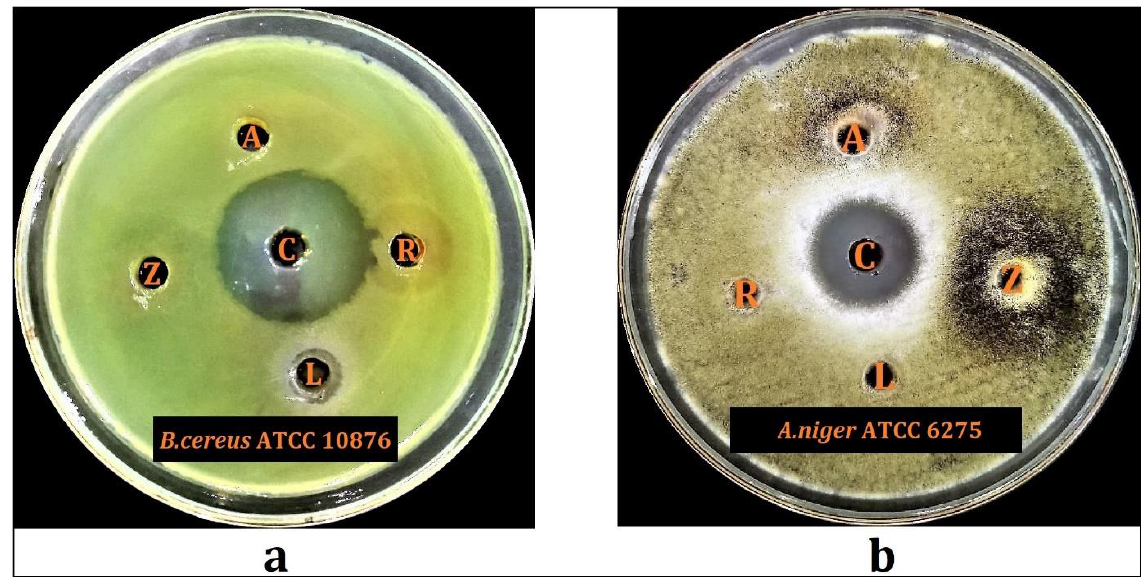
Figure 5. Results of preliminary antimicrobial activity evaluations against, ( a ) B. cereus 10876; ( b ) A. niger 6275 for Lycium shawii ( L ), Anabasis articulata ( A ), Rumex vesicarius ( R ), Zilla spinosa ( Z ) plants’ hydroalcoholic extracts, and control antibiotics ( C ). Table 6. Results of MIC and MBC of Lycium shawii (L), Anabasis articulata (A), and Zilla spinosa (Z) hydroalcoholic plant extracts and positive controls (PC).